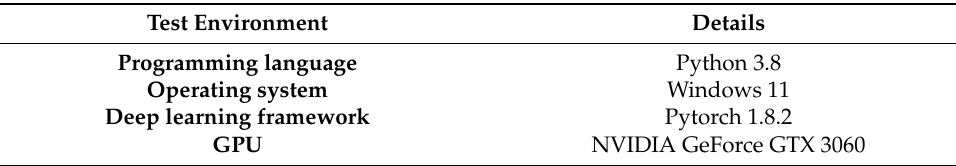
Table 1. Model test environment.